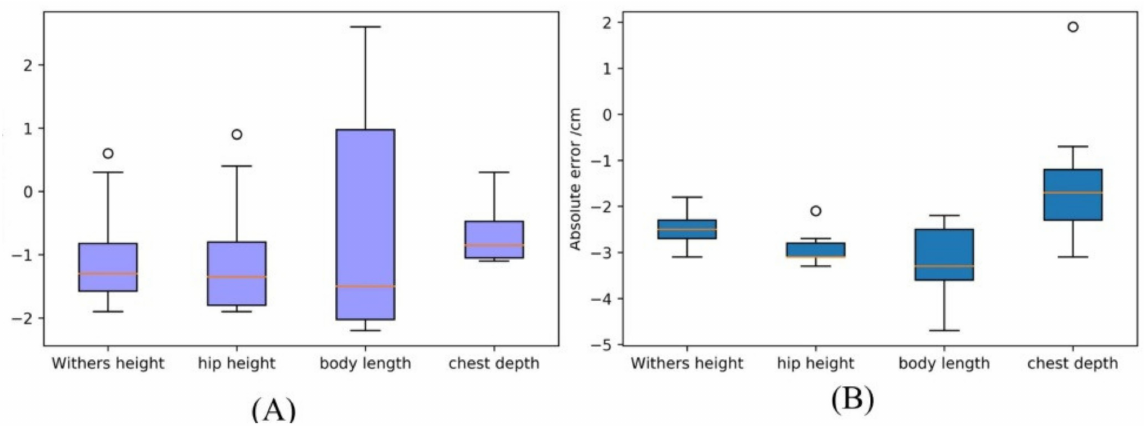
Figure 17. Box plots of the absolute error: ( A ) Box plots of the absolute error of the measurement of the cattle body size; ( B ) Box plots of the absolute error of the measurement of the goat body size.